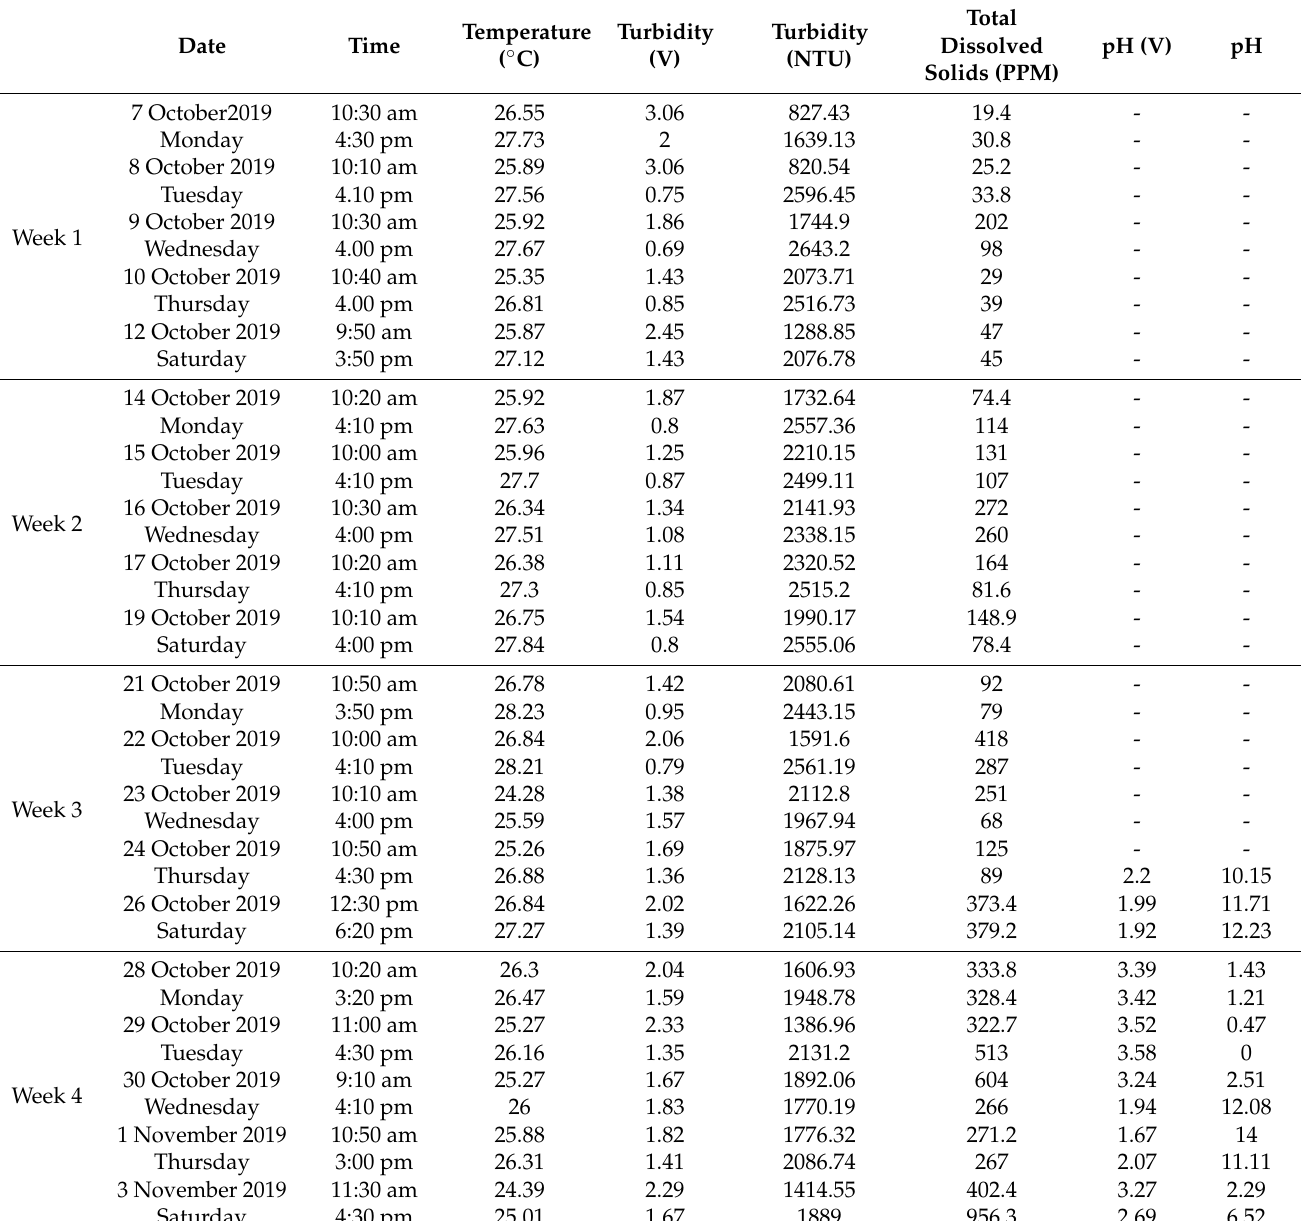
Table 4. Data for the duration of the